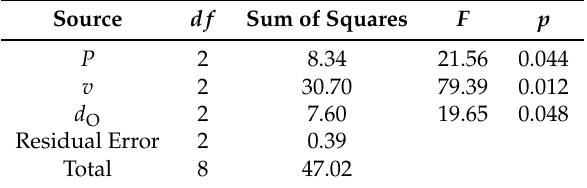
Table 5. Analysis of variance for S/N ratios of vertical surfaces (contour), R 2 = 99.18%.